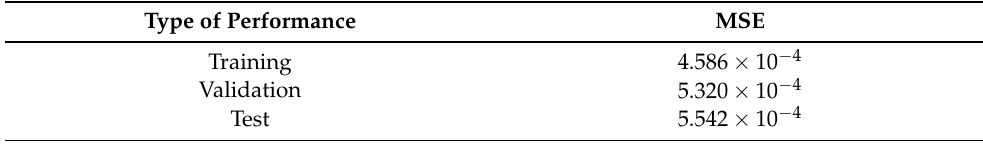
Table 7. Performances for Extended Case A.